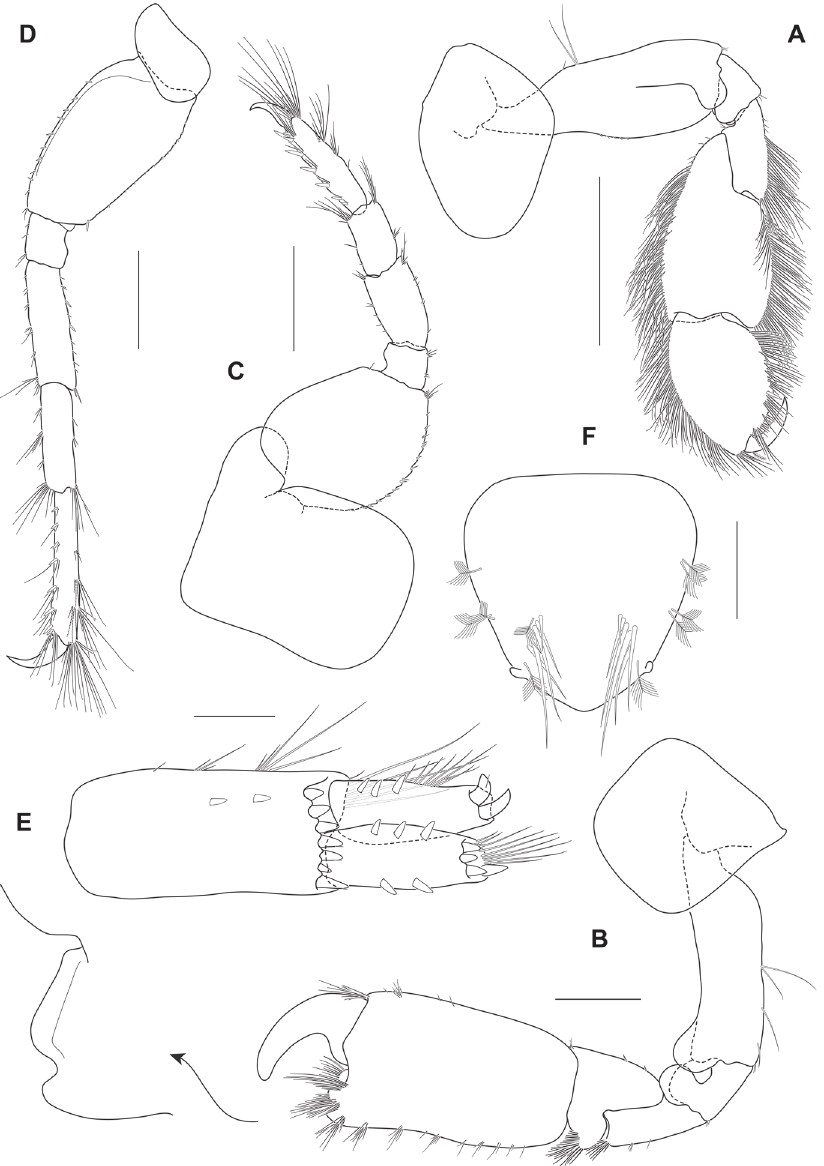
Figure 3. Ampithoe changbaensis sp. nov., male holotype A gnathopod 1 B gnathopod 2 C pereopod 5 D pereopod 7 E uropod 3 F telson. Scale bars: 2 mm ( A–D ); 0.25 mm ( E, F